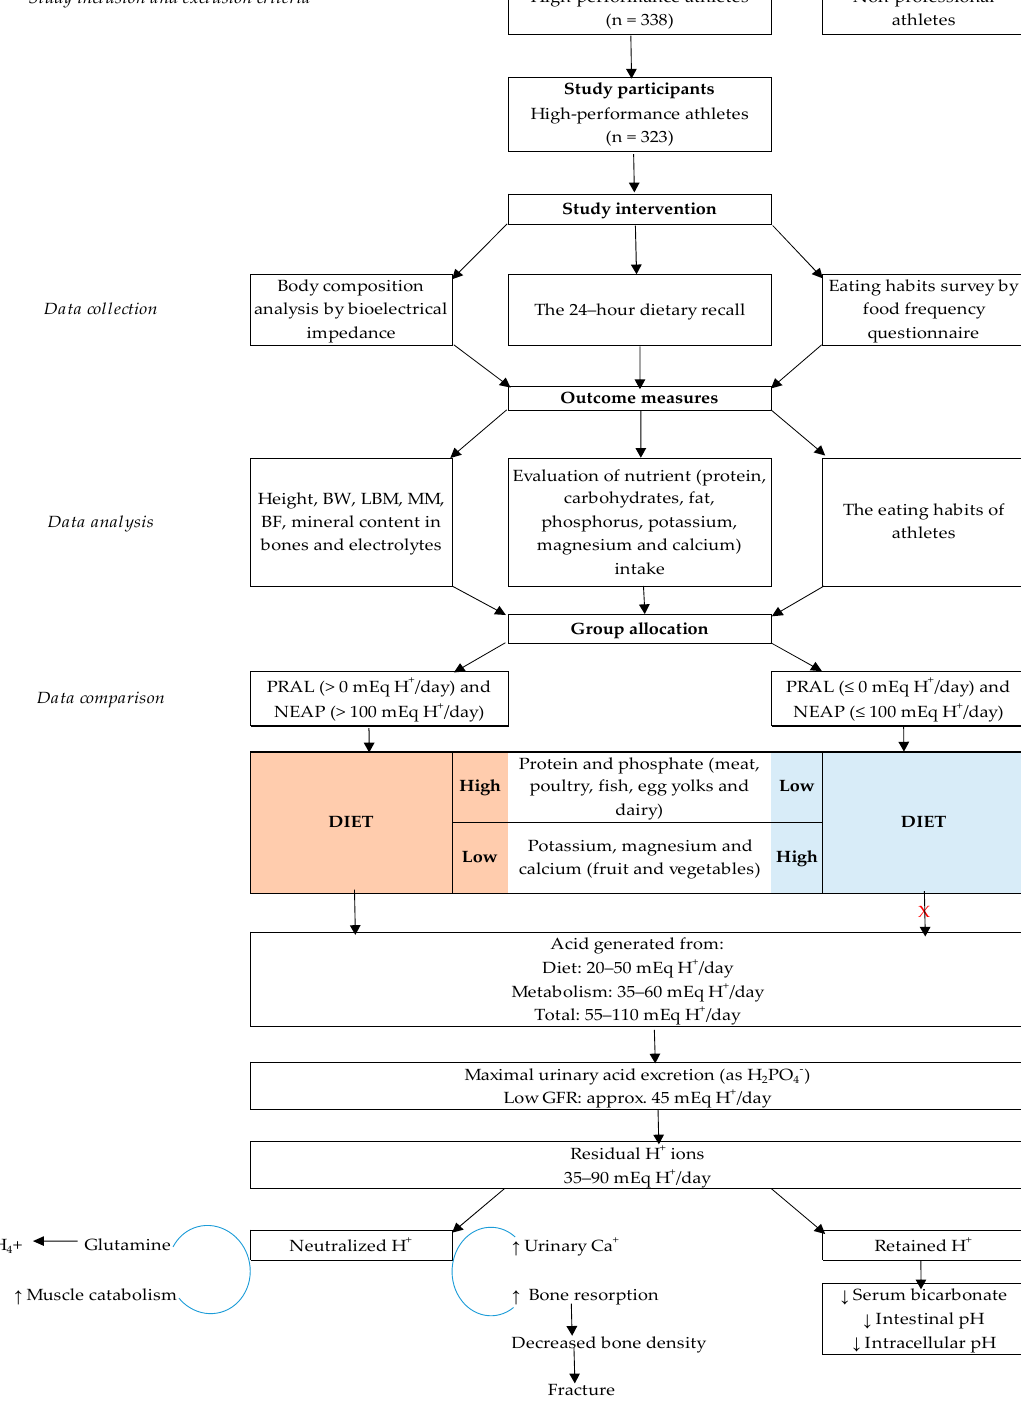
Figure 1. Flowchart of the enrollment of athletes and study procedures. BW—body weight; LBM—lean body mass; MM—muscle mass; BF—body fat; PRAL—potential renal acid load; NEAP—net endogenous acid production; GFR—glomerular filtration rate.